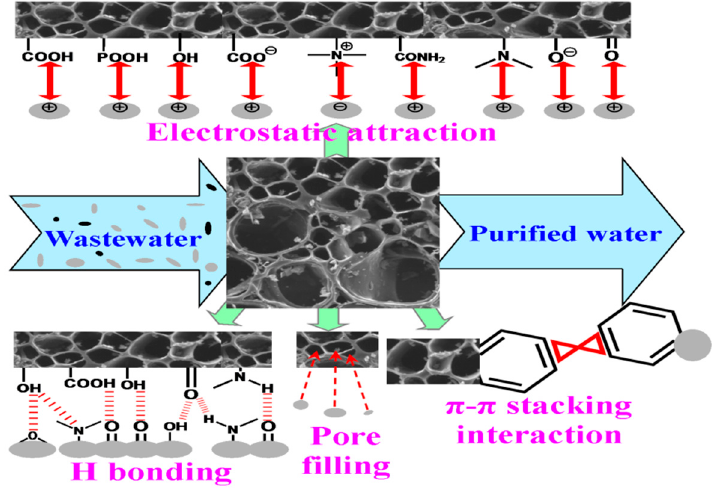
Figure 5. Postulated mechanisms of the interactions of pollutant with activated carbon.